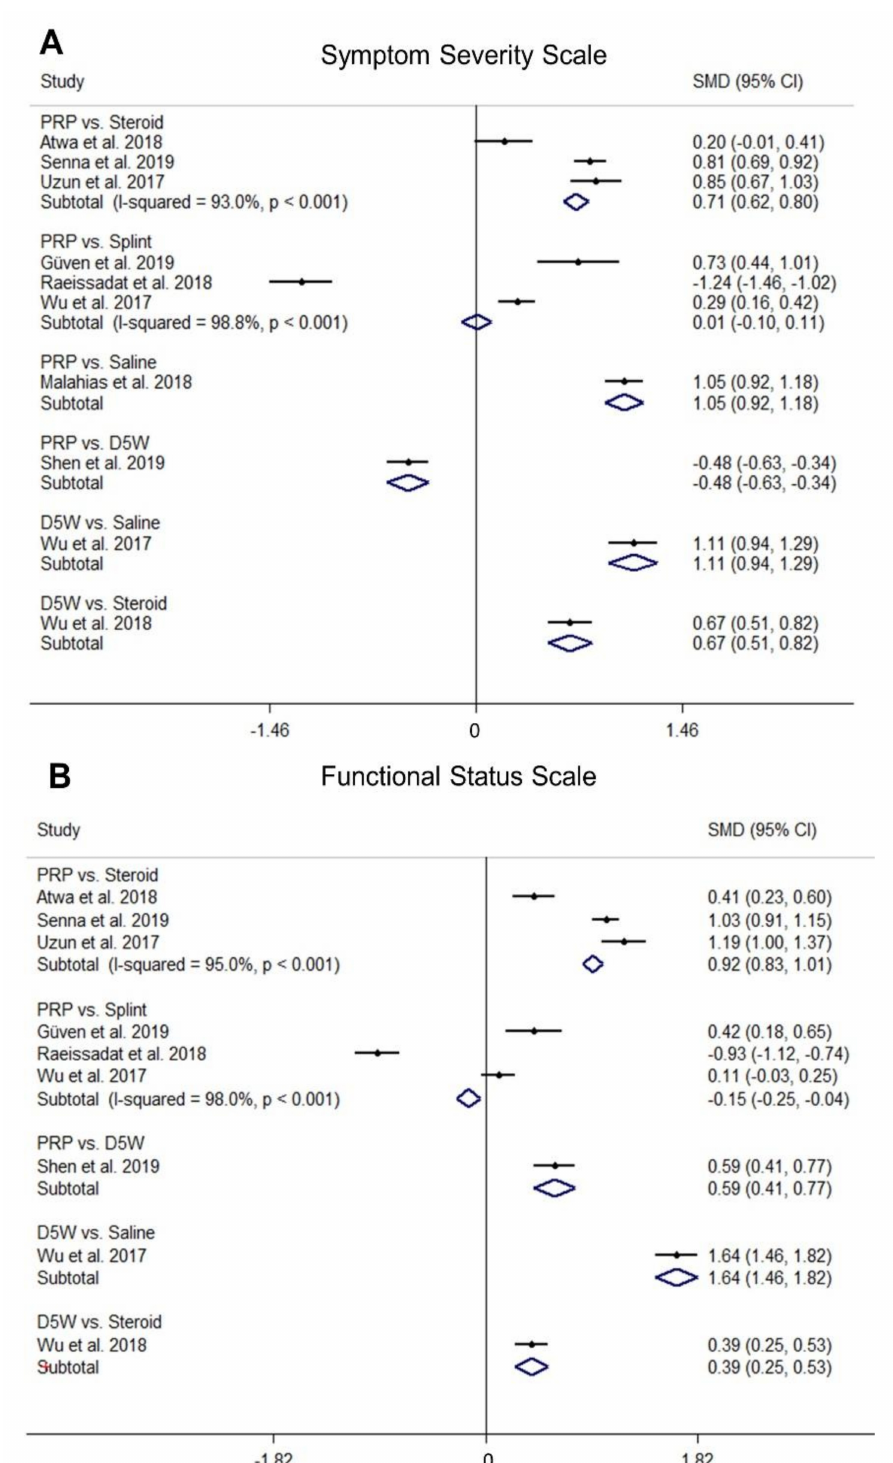
Figure 2. Forest plot of pairwise comparisons of the standardized mean di ff erence (SMD) between di ff erent subgroups in terms of the ( A ) symptom severity scale and ( B ) functional status scale of the Boston Carpal Tunnel Questionnaire. PRP, platelet-rich plasma; D5W, 5% dextrose. On the other hand, selective reporting was revealed to have a low risk of bias in the majority of the enrolled trials. Almost all of the studies reported the outcome by using acceptable clinical assessment tools, together with electrophysiological